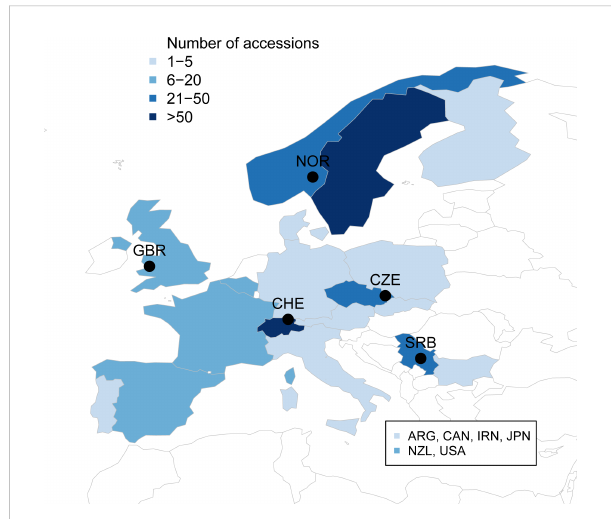
FIGURE 1 Origin and number of the European accessions in the EUCLEG red clover panel. Additional accessions from Argentina (ARG, 5), Canada (CAN, 1), Iran (IRN, 1), Japan (JPN, 2), New Zealand (NZL, 10) and USA (10) are not shown on the map. Locations of the fi eld trials in Norway (NOR), Great Britain (GBR), Switzerland (CHE), Czech Republic (CZE) and Serbia (SRB) are indicated by black